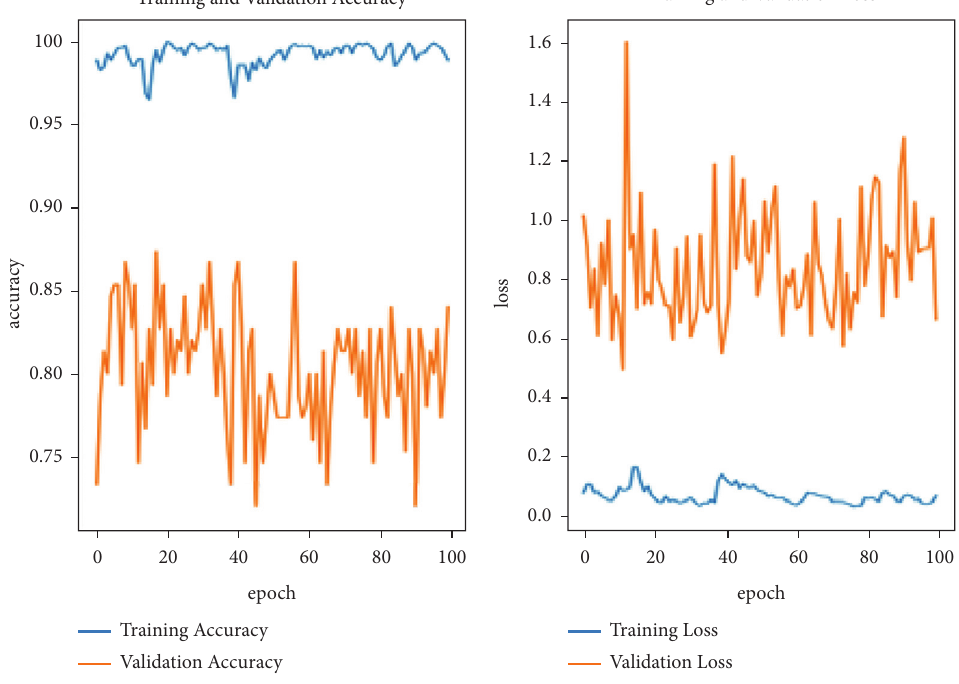
Figure 11: Accuracy and loss with ensemble transfer learning Table 4: Performance analysis proposed method with the different models.